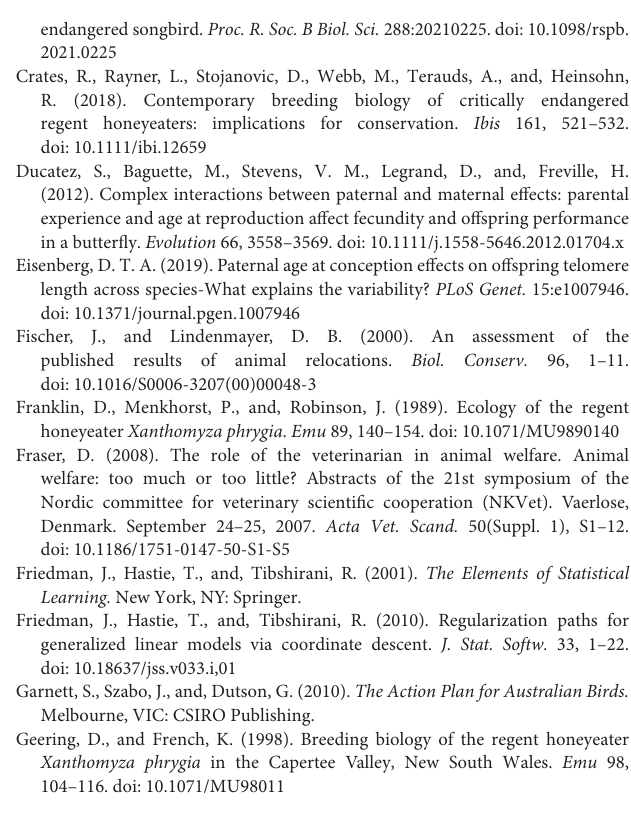
Supplementary Figure 1 | Coefficient paths and model selection criteria for one imputation of the data. Candidate models are indexed by the parameter lambda, which shrinks coefficients toward exactly zero as it increases (bottom plot). The top plots show the model selection criteria (cross validation or AIC). The model with the lowest value of the model selection criteria is chosen (vertical dashed line), with predictors with non-zero coefficients making up the final model. In both breeding models for females, the model chosen is the one without any